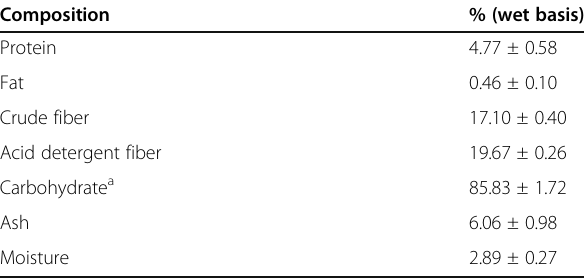
Table 1 Proximate composition of DRP